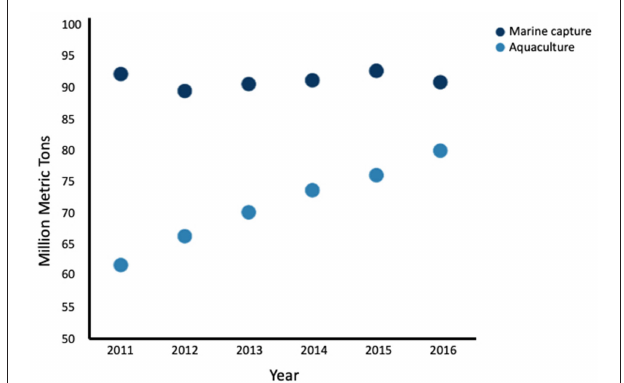
FIGURE 2 | Global seafood production by marine capture and aquaculture by year from 2011 to 2016. Aquaculture production has increased while marine capture has remained fairly constant. Fish, crustaceans, mollusks and other aquatic animals are included, and aquatic mammals, crocodiles, caimans, seaweeds, and other aquatic plants are excluded Data adapted from the FAO